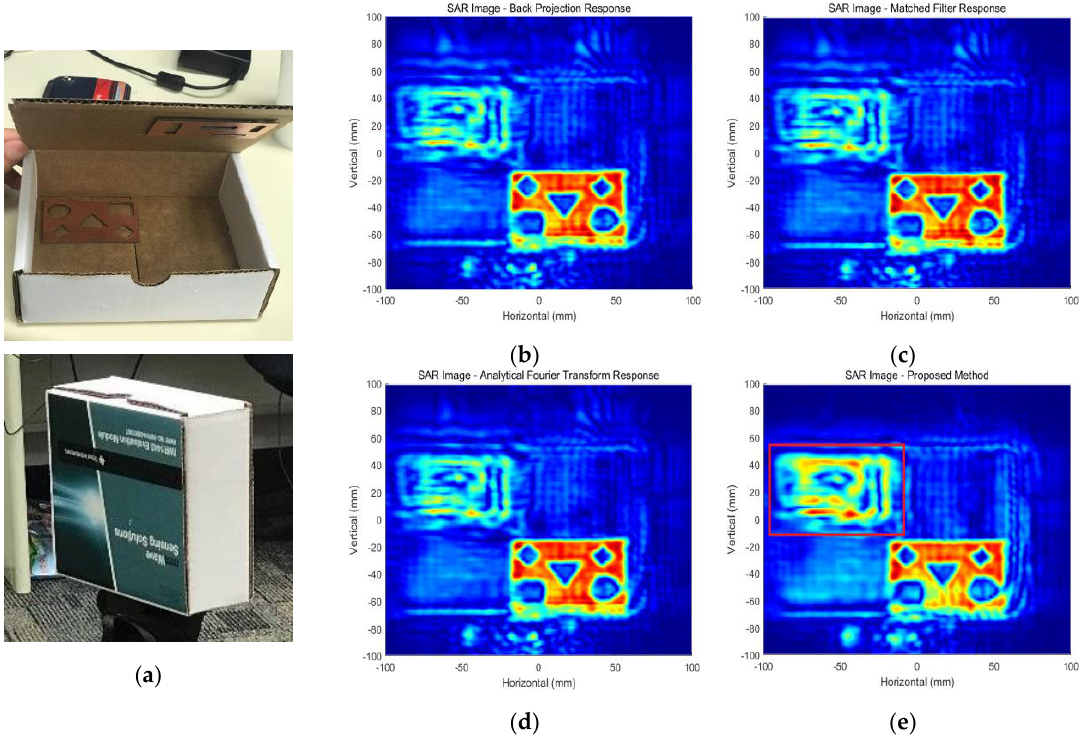
Figure 13. Hidden and Different-Distance multiple targets: ( a ) scenario; ( b ) Back Projection; ( c ) Matched Filter; ( d ) Analytic Fourier Transform; ( e ) mmSight (red frame: projection of other target).